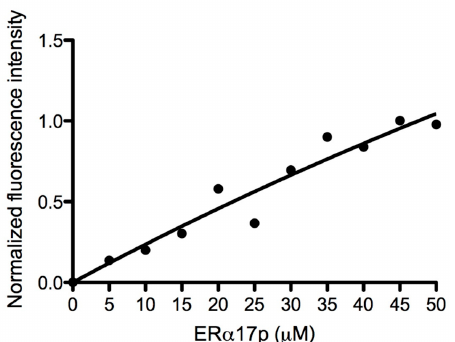
Figure 4. ER α 17p / Grb2 SH3 domain interaction study by fluorescence spectroscopy. Fluorescence Figure 4. ER α 17p/Grb2 SH3 domain interaction study by fluorescence spectroscopy. Fluorescence changes of the sole tryptophan of the Grb ‐ SH3 domain (1 μ M in 50 mM Tris buffer adjusted to pH 8) changes of the sole tryptophan of the Grb-SH3 domain (1 µ M in 50 mM Tris bu ff er adjusted to pH 8) by ER α 17p upon successive addition of 5 µ L at 10 − 3 M in Tris bu ff er. Measurements were performed at 18 ◦ C. The λ exc and λ em values were 280 nm and 350 nm, respectively. Experimental data points have been fitted with the software Prism